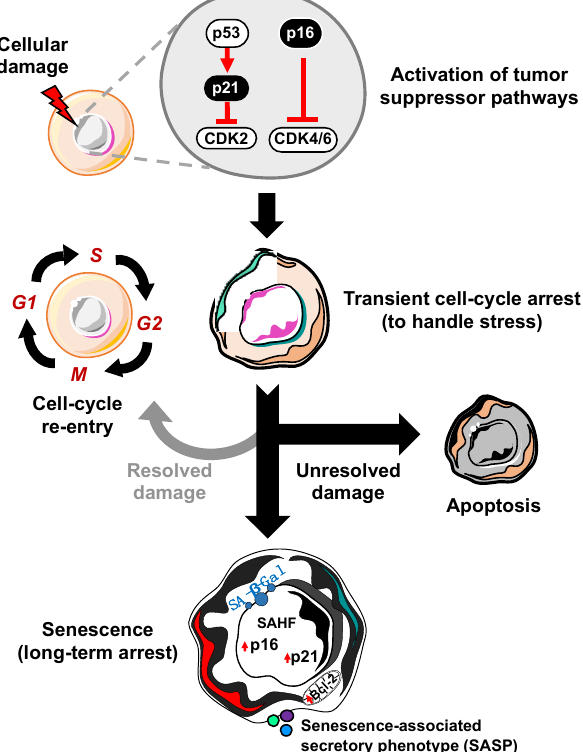
Figure 1. Process of cellular senescence. In response to cellular damage, the cell activates a myriad of pathways including the p53-p21 and p16-RB tumor suppressor pathways for transient cell-cycle arrest to handle and repair the stress. If the damage is repaired, it can re-enter the cell-cycle. However, if the damage is unresolved, the cell has two main fates: apoptosis (cell death) or cellular senescence, characterized by increased expression of cyclin-dependent kinase inhibitors (i.e., p16, p21), senescence-associated heterochromatin foci (SAHF), Bcl-2 anti-apoptotic proteins, senescence-associated beta-galactosidase (SA- β -Gal), and the senescence-associated secretory phenotype (SASP).